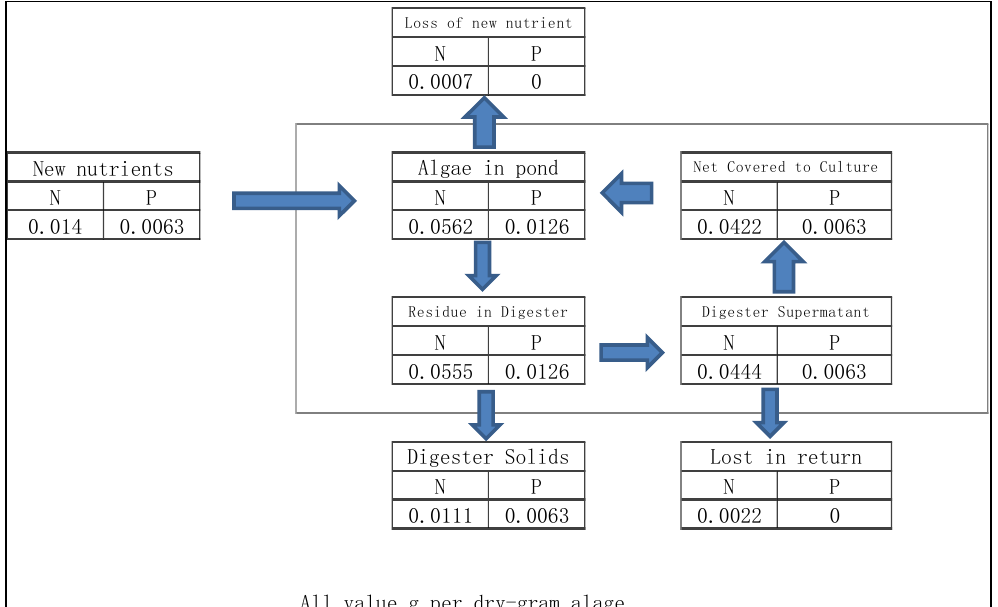
Figure 5. N and P flows of the algae